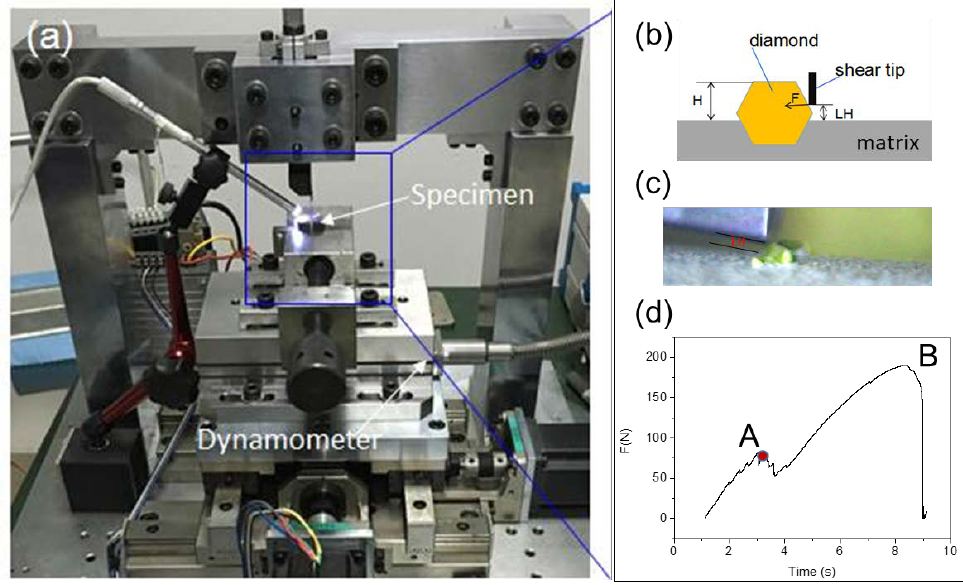
Figure 1. Illustration of shearing test: ( a ) shearing test device; ( b ) schematic of shearing; ( c ) real shearing; ( d ) shearing force signal.